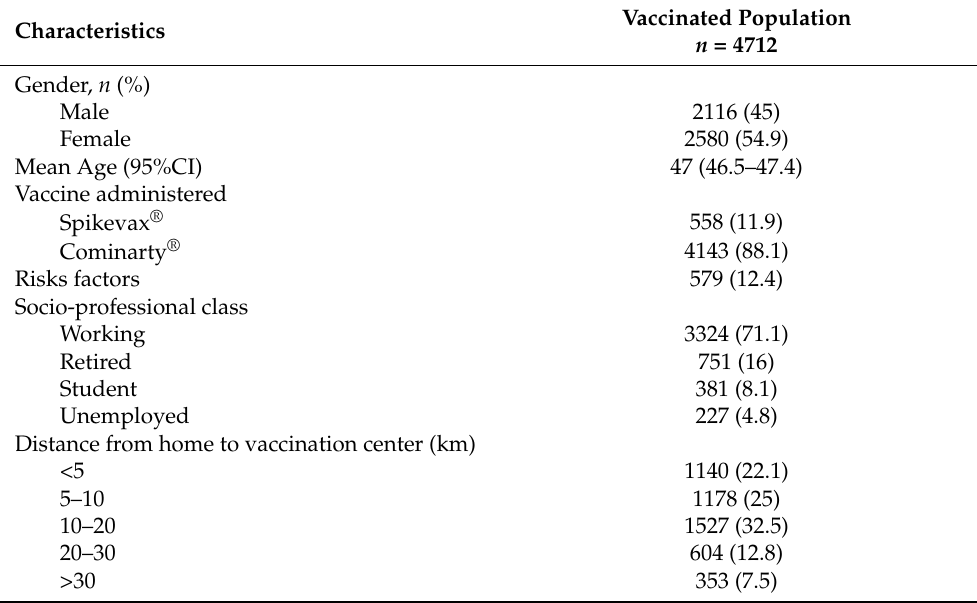
Table 2. Demographic characteristics of survey respondents.